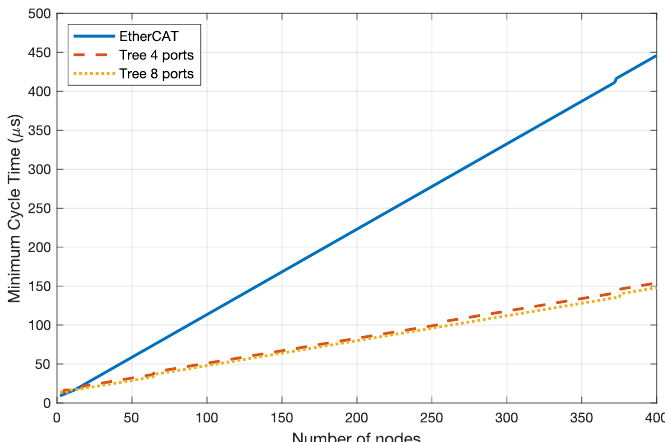
Figure 2. Minimum Cycle Time for the ring (EtherCAT) and tree (Fast Ethernet) network topologies, when broadcasting information from the master controller to cells,